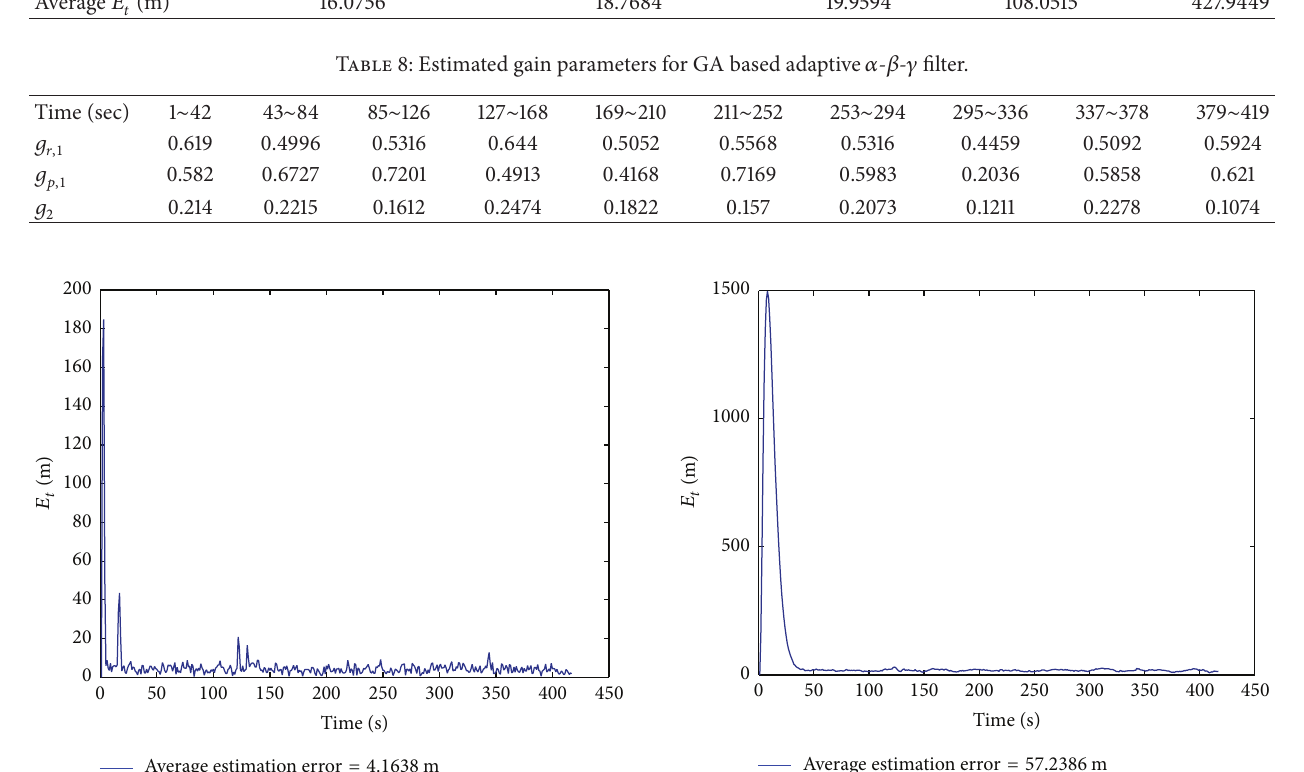
Figure 25: Estimation error of 𝛼 - 𝛽 - 𝛾 filter with 𝑔 𝑟,1 = 𝑔 𝑝,1 = 𝑔 2 = 0.75